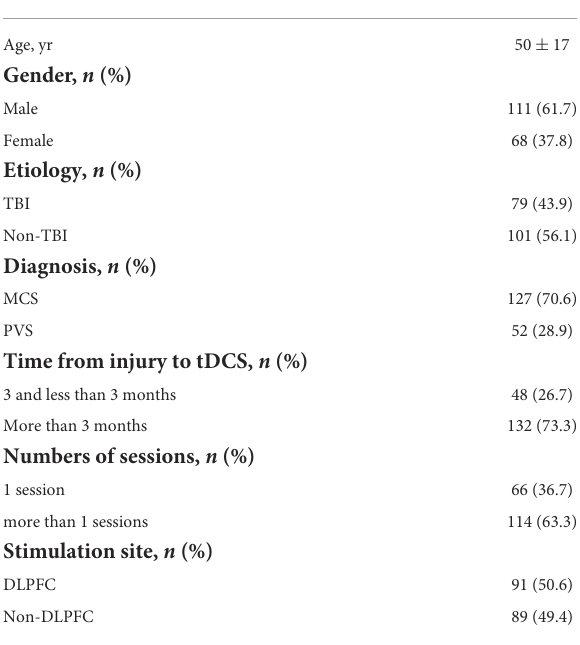
TABLE 2 Overview of patient and protocol